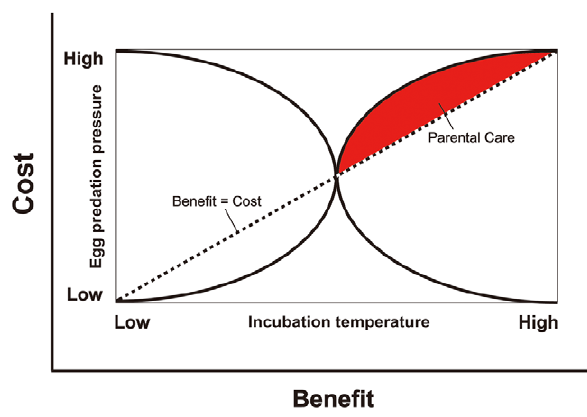
Figure 1. A hypothetical cost-benefit model describing the evolution of parental care in long-tailed skinks ( Eutropis longicaudata ), showing how parental care can evolve based on the relationship between incubation temperature (the benefit is increased hatching success, x-axis) and egg preda- tion pressure from snakes (the cost of laying eggs in populations with varying snake population size, y-axis). Note that these relationships are hypothetical, and provide only one example of how these two variables could influence the evolution of maternal care (similar relationships can be developed between other variables of interest). Parental care has a high likelihood of evolving in instances where female lizards select nest sites that are relatively high (i.e., inside of a retaining wall as compared to in natural habitats) but in which there are large numbers of egg-eating snakes (and thus high risk of any eggs left unattended becoming depredated). This matches the situation on Orchid Island, Taiwan. Maternal care is unlikely to evolve when predation pressure is relatively low, which matches the situation on Green Island and mainland